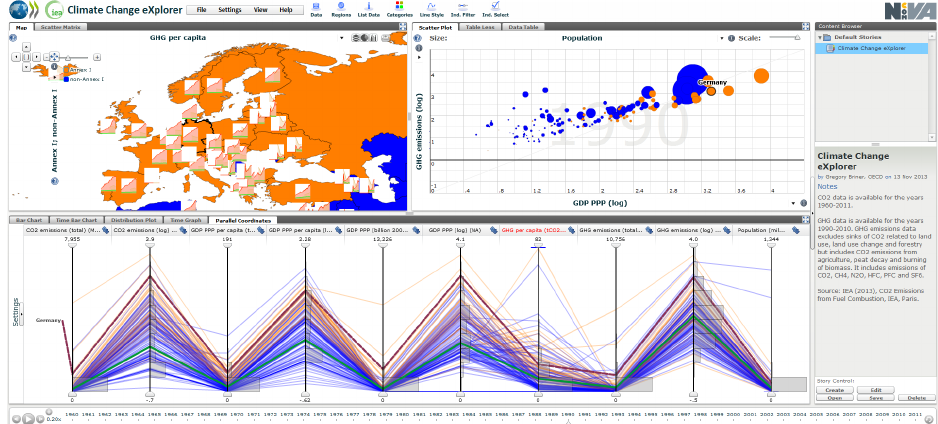
Figure 14. Screenshot of the climate explorer web tool [34] used to visualize emission data.